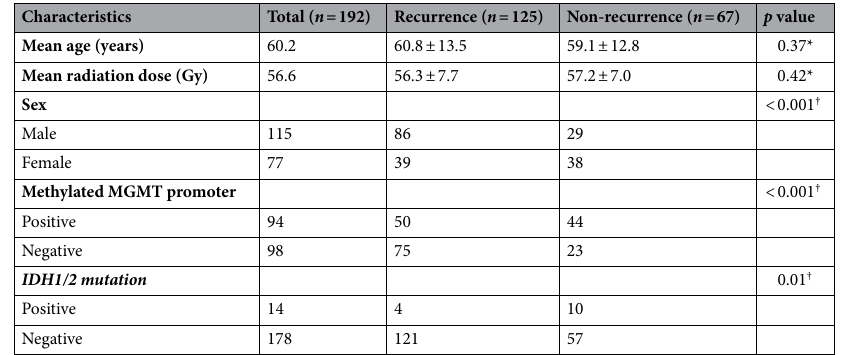
Table 1. Clinical characteristics of the study population. Unless otherwise specified, data are given as the number of patients. Data are expressed as mean ± standard deviation; MGMT , O6-Methylguanine-DNA methyltransferase; IDH , Isocitrate dehydrogenase. *Calculated with an unpaired Student’s t test. † Calculated with Fisher’s